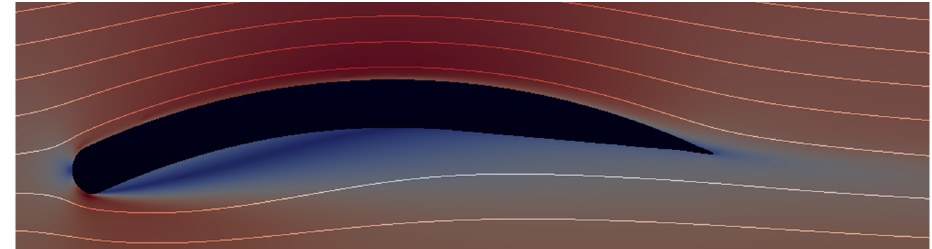
Figure 6. Contour map of the flow velocity (122 m/s) of the NACA 6412 profile from the left: for a zero and a five-degree angle of attack of the profile.